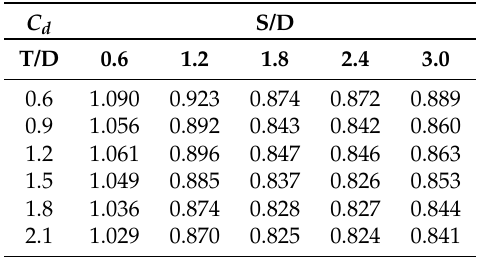
Table 2. C d of the circular cylinder with two passive